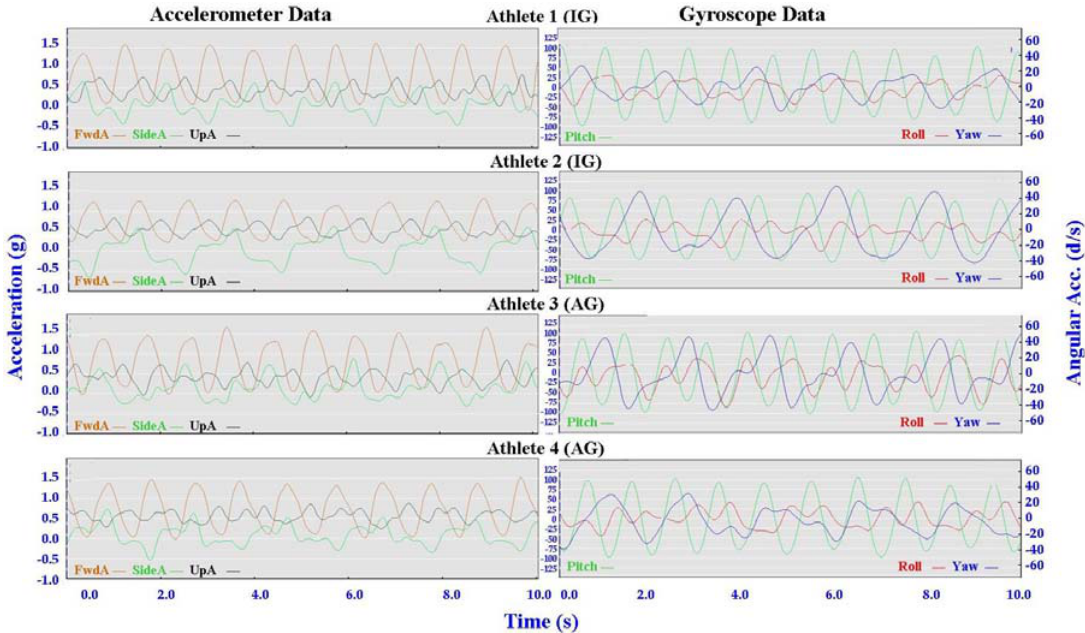
Figure 14. Comparison of Double Time (G3) gyroscope and accelerometer traces for four athletes (two from the IG and two from the AG).